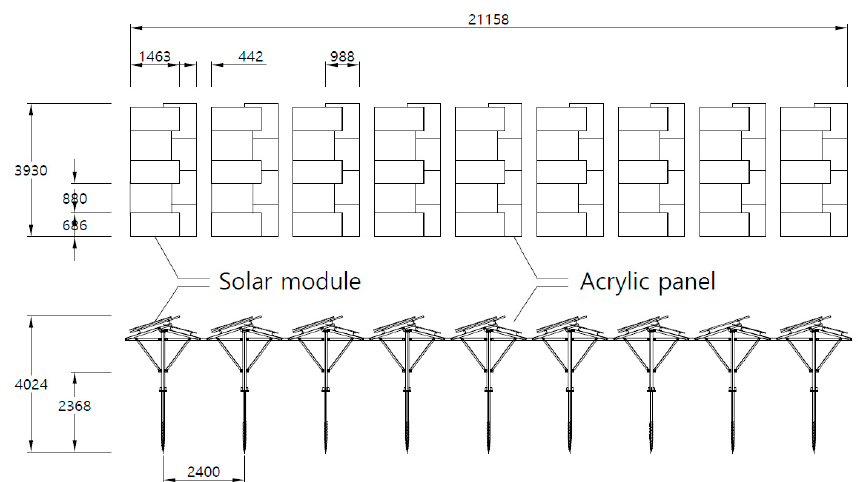
Figure 4. Structure of photovoltaic system.